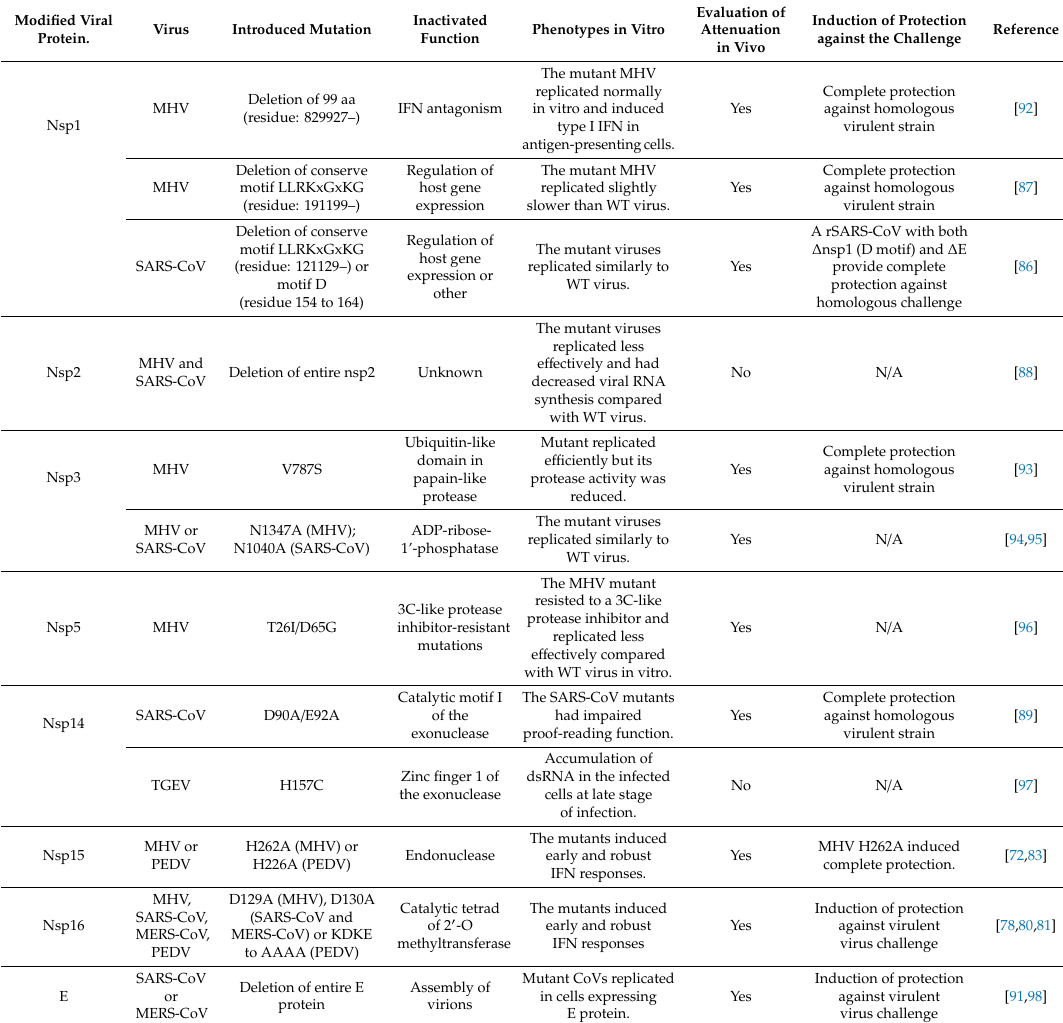
Table 2. Summary of recombinant coronaviruses (CoVs) with virulence-associated modifications (without S and ORF3 proteins). ModifiedViral